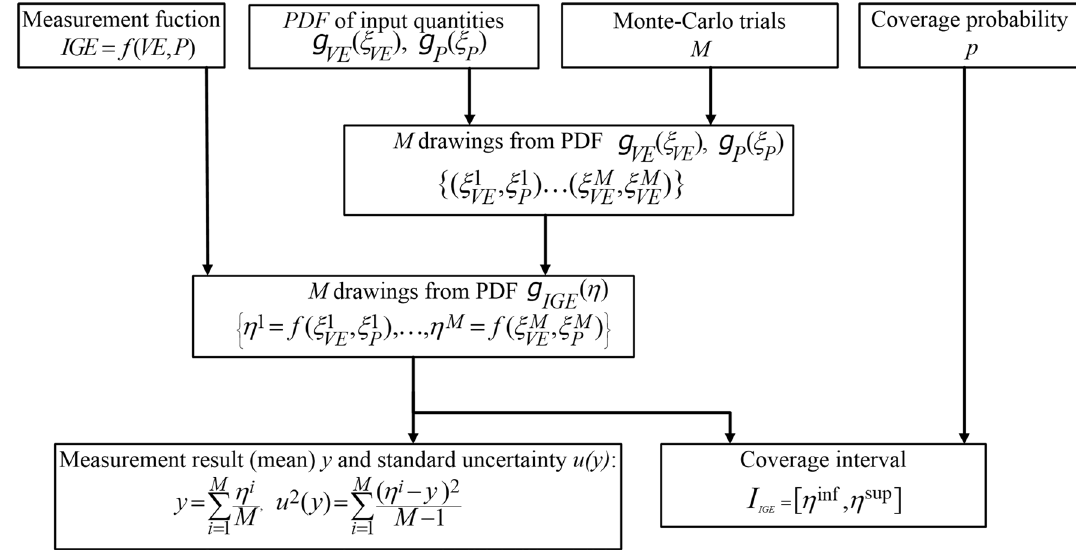
Fig. 1 The procedure of the GUM S1 method applied to the effluent generation